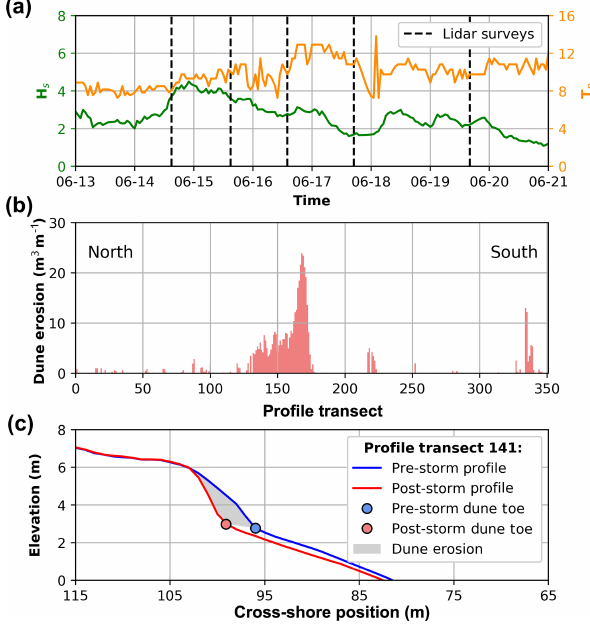
Figure 6. June 2011 storm data. (a) Offshore H s and T p with ver- tical dashed lines indicating the time of the lidar surveys, (b) mea- sured (pre- vs. post-storm) dune erosion volumes for the 351 profile transects extracted from lidar data, and (c) example pre- (blue) and post-storm (red) profile cross sections showing dune toes (coloured circles) and dune erosion volume (grey